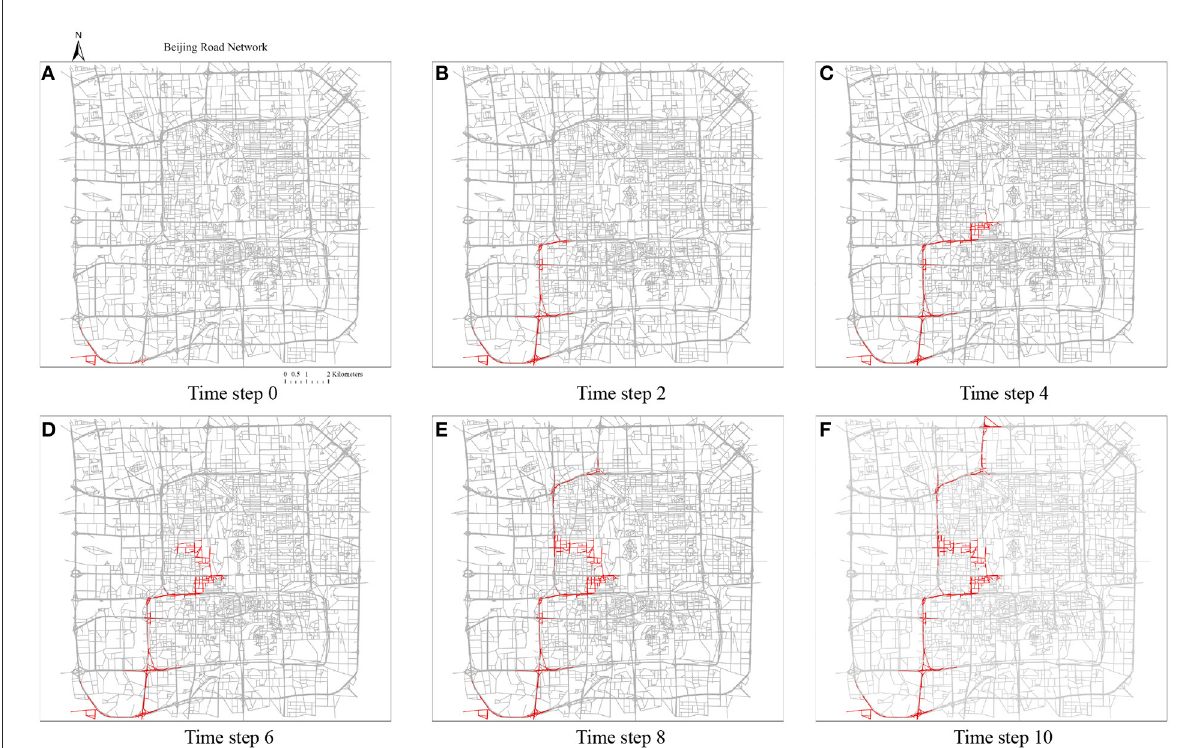
FIGURE12 The trajectories of superspreader-based infections propagation. The traveling speed is set as 10 road segments/time step. The closest five segments adjacent to the traveler are assumed to be infected. The total moving time is 11 time steps. (A) Time step 0, (B) time step 2, (C) time step 0, (D) time step 6, (E) time step 8, (F) time step